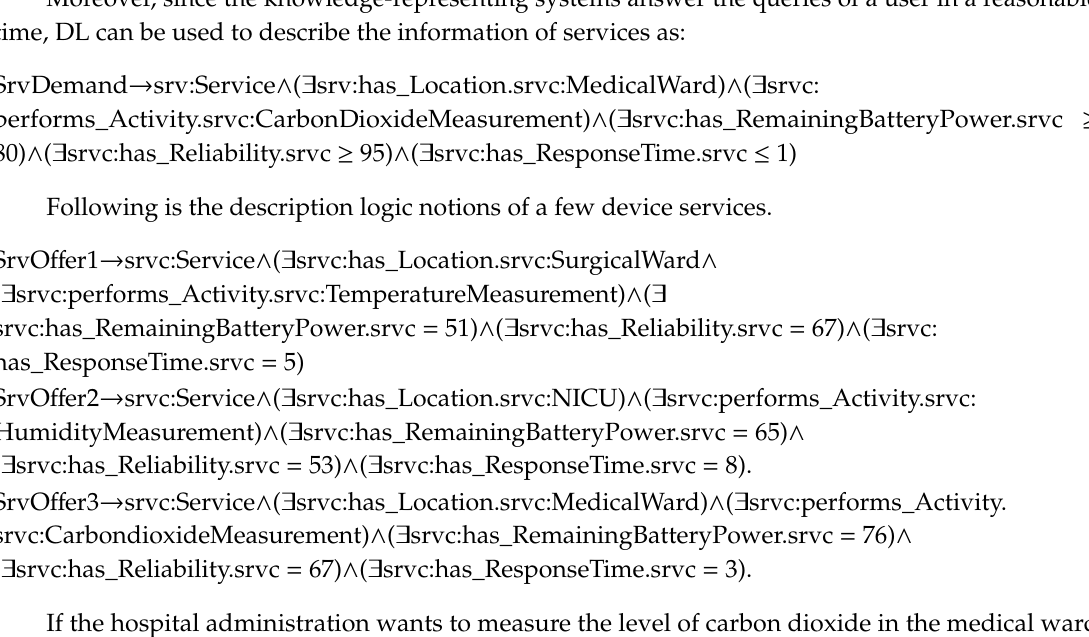
Figure 3. Unified Modeling Language (UML) Meta-model for autonomous mobile robot ontology.